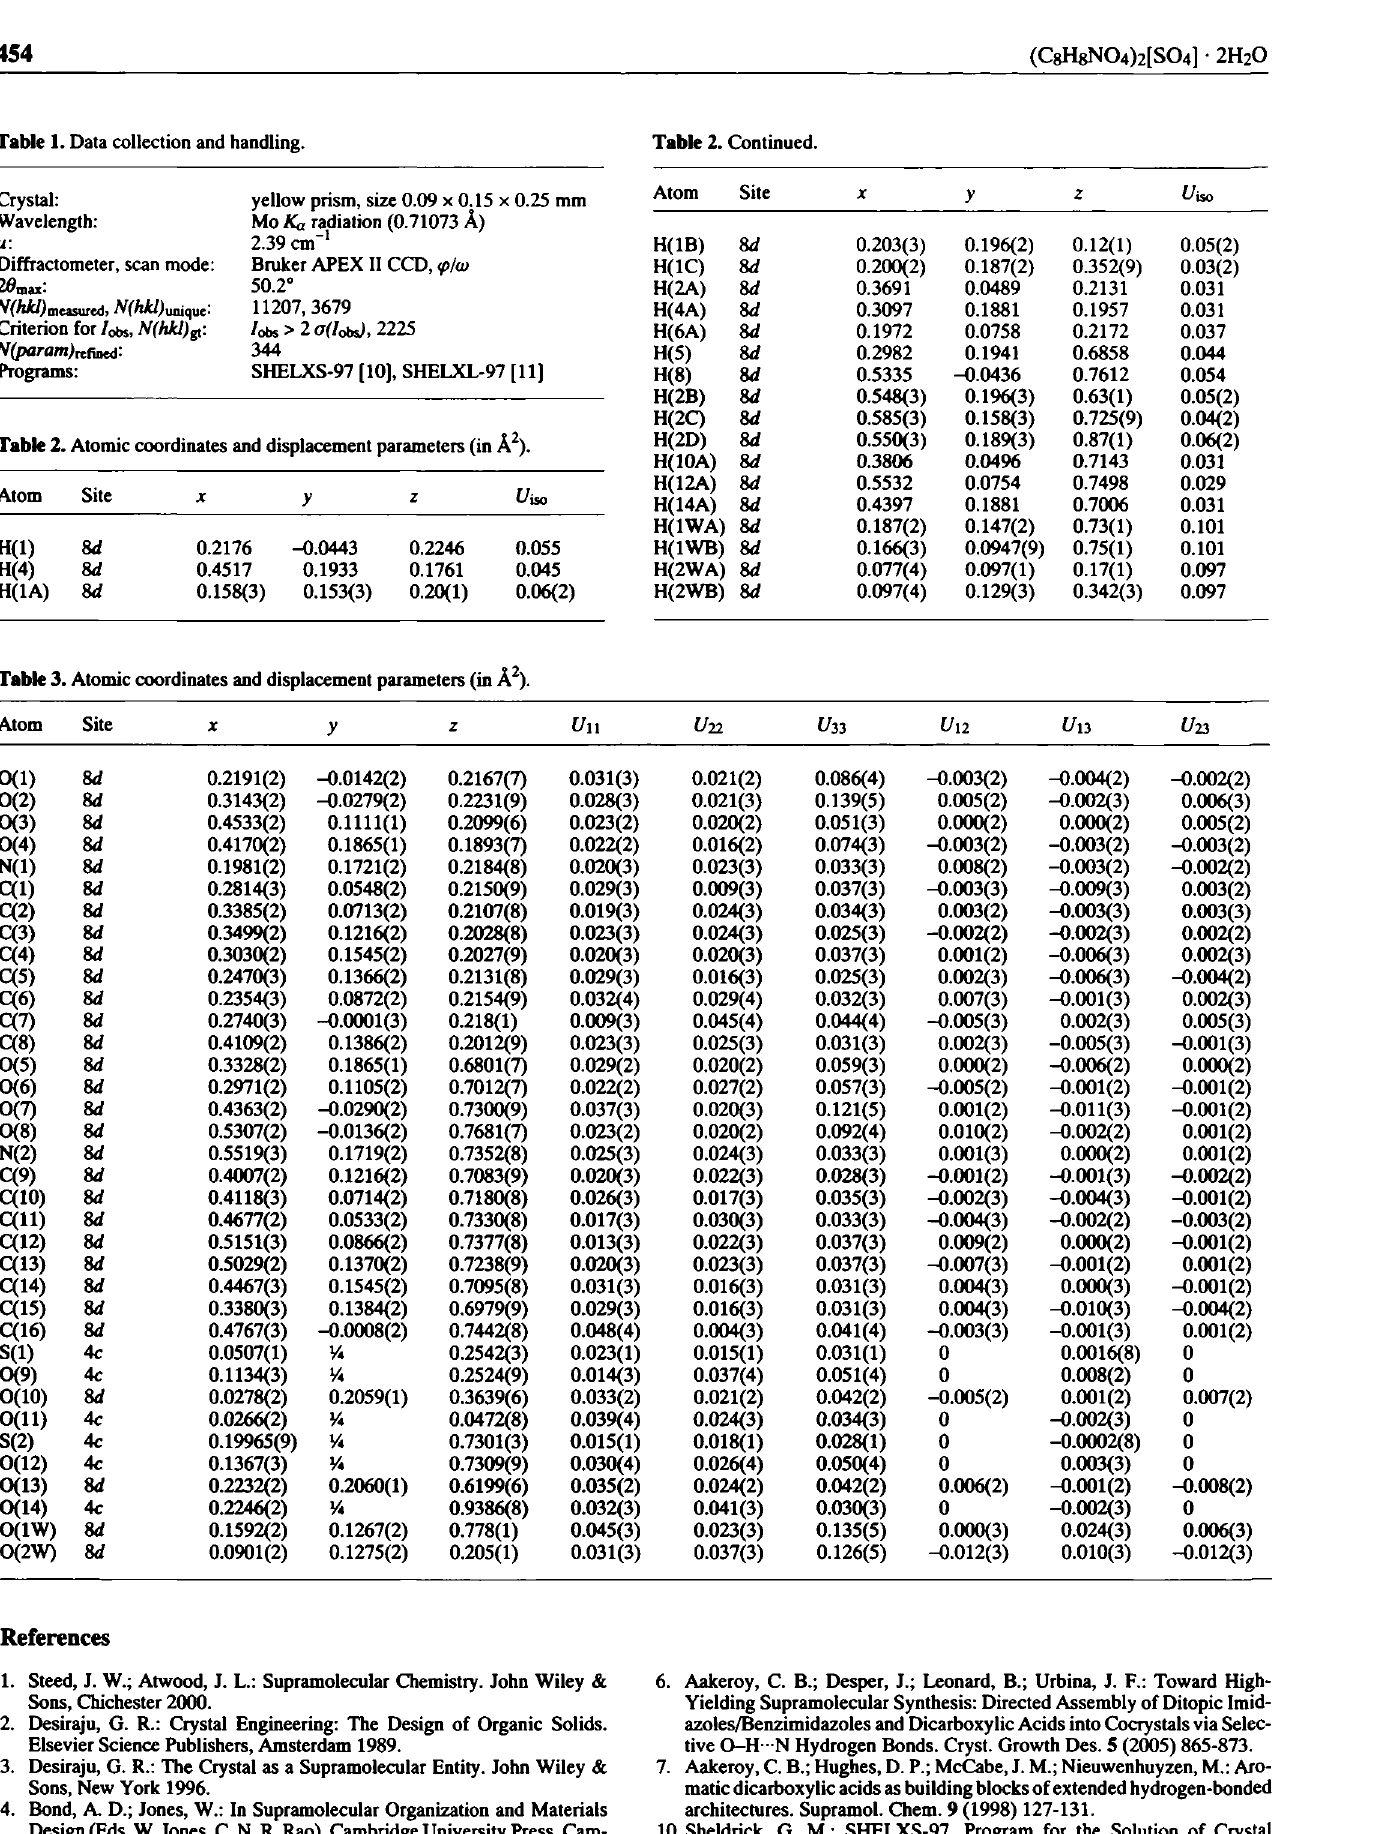
Table 2. Atomic coordinates and displacement parameters (in A 2 ).